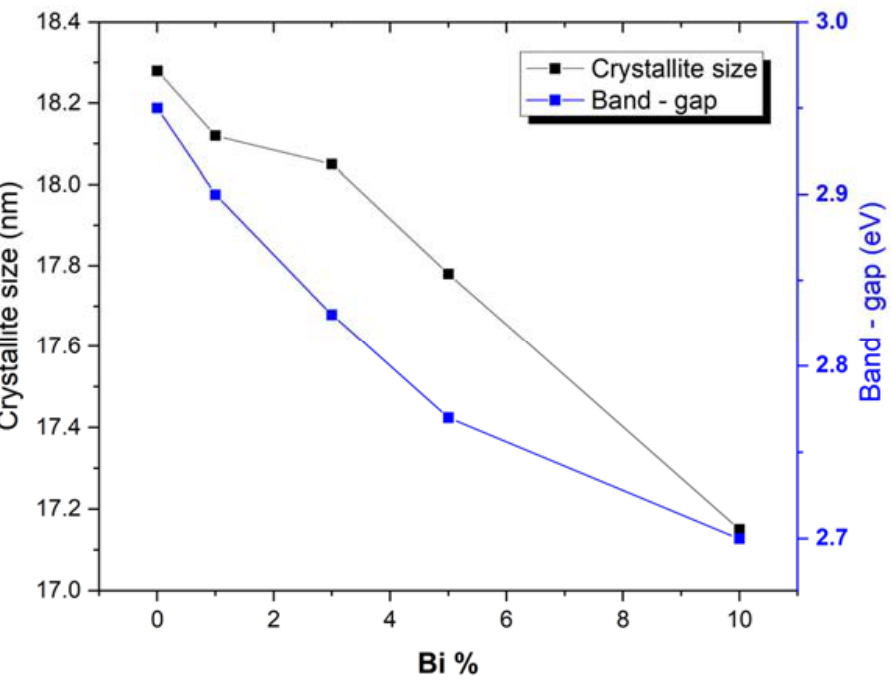
Figure 9. Effect of bismuth content loading on the crystallite size and band gap (E g ) of the Bi-doped TiO 2 samples obtained by mechanosynthesis.